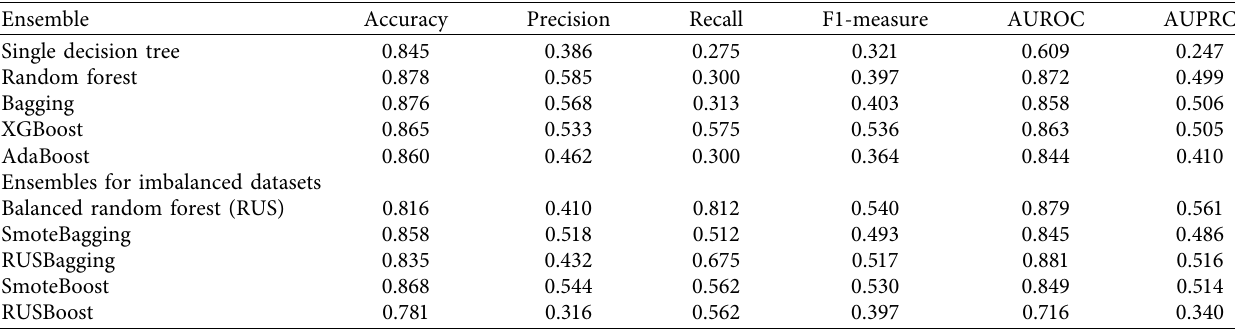
Table 2: The comparative study of various ensemble methods. Different performance measures are used to study their performance.